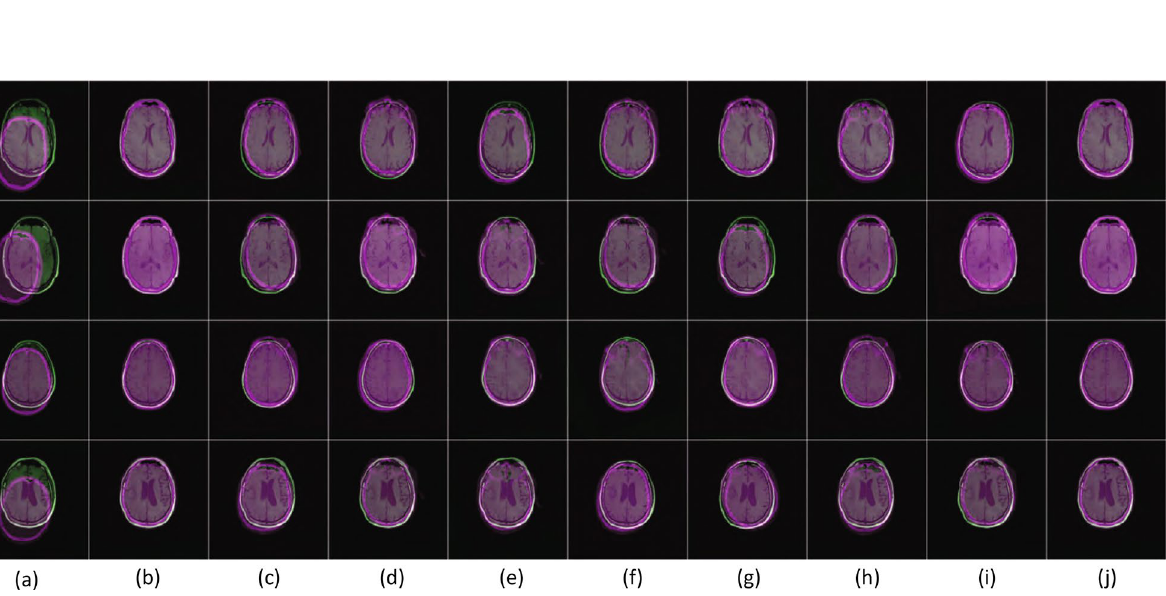
Table 2. MRI and CT images registration performance (when the existing DNNs are used as feature extraction and coupled with a regression ANN). Best result for each metric is shown in bold.